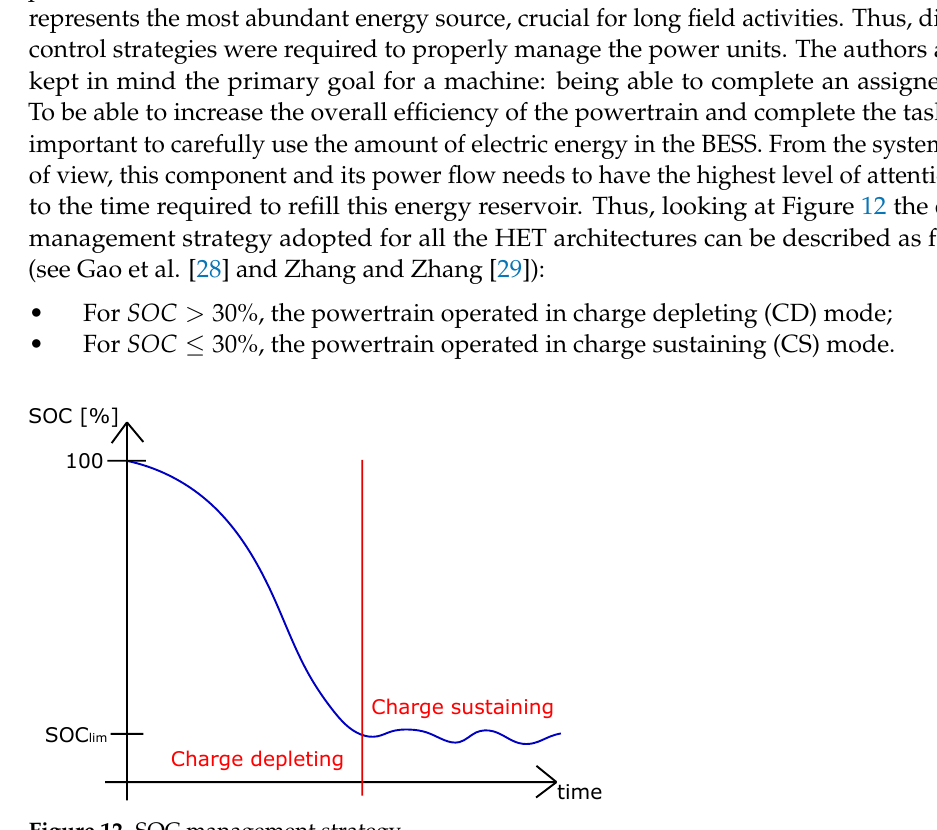
Figure 12. SOC management